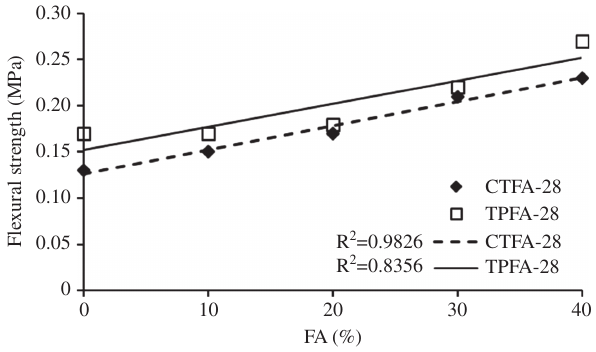
Figure 7 Flexural strength of specimens exposed to freeze-thaw.